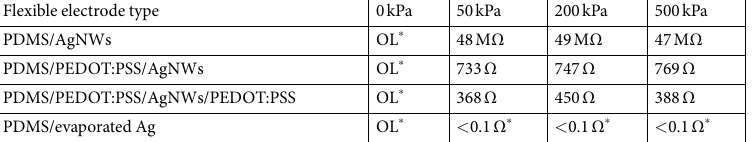
Table 1. Measured resistance of PDMS-based flexible electrodes at various pressure. * OL (Overload) and < 0.1 Ω correspond to the upper and lower limits of the measuring equipment,